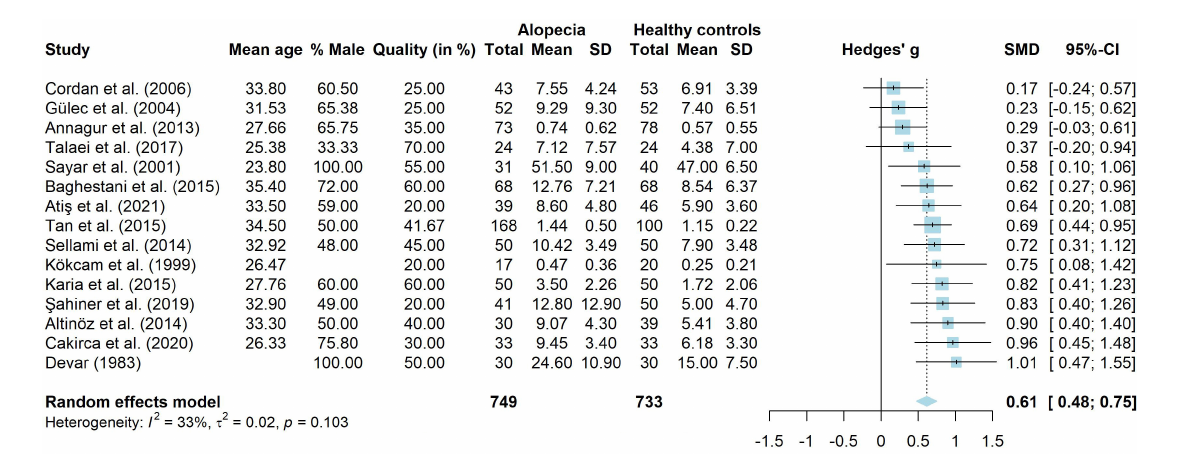
FIGURE2 Forest plot for symptoms of anxiety in adults with alopecia compared to healthy